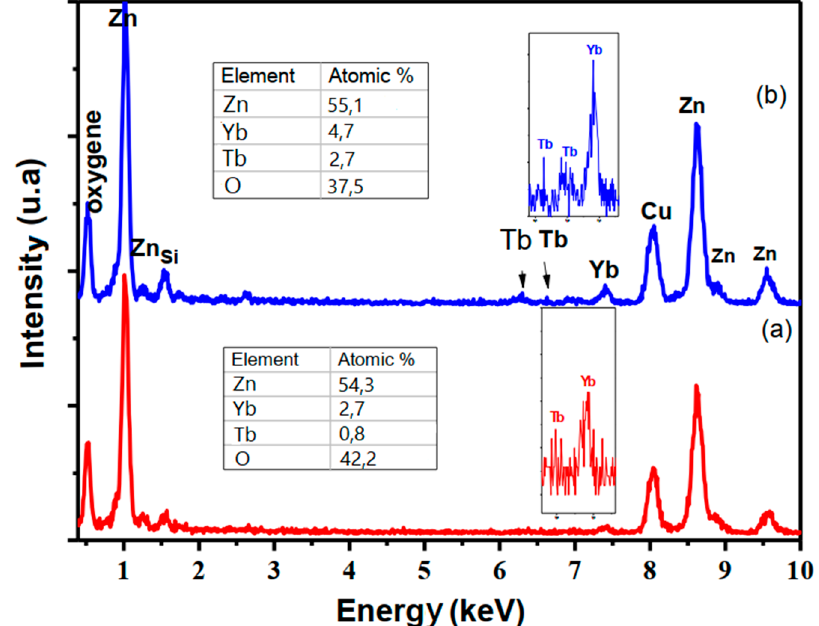
3 + / Tb 3 + co-doped ZnO thin films with the following Tb Figure 2. Typical EDX spectra of Yb 3+ /Tb 3+ co-doped ZnO thin films with the following Tb doping Figure 2. Typical EDX spectra of Yb